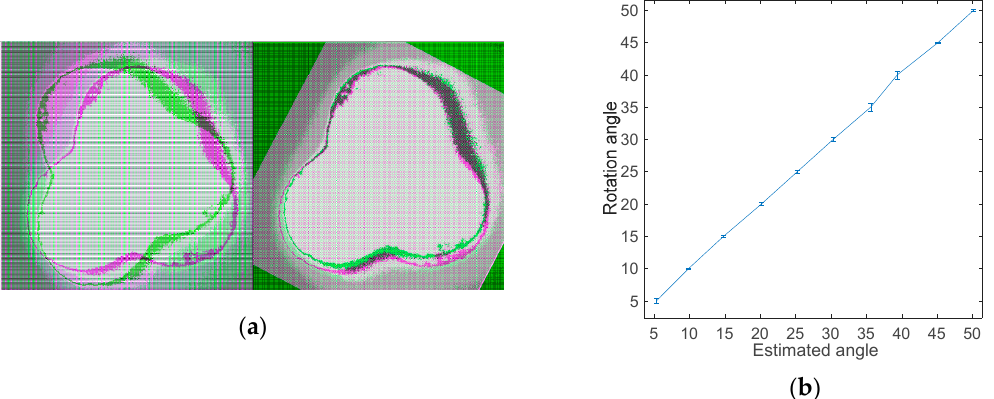
Figure 6. ( a ) Reference and rotated image superimposed before and after the registration algorithm is applied. ( b ) Comparison between the retrieved angles using the registration algorithm and the rotation angles applied. The error bars show the average error for ten measurements.